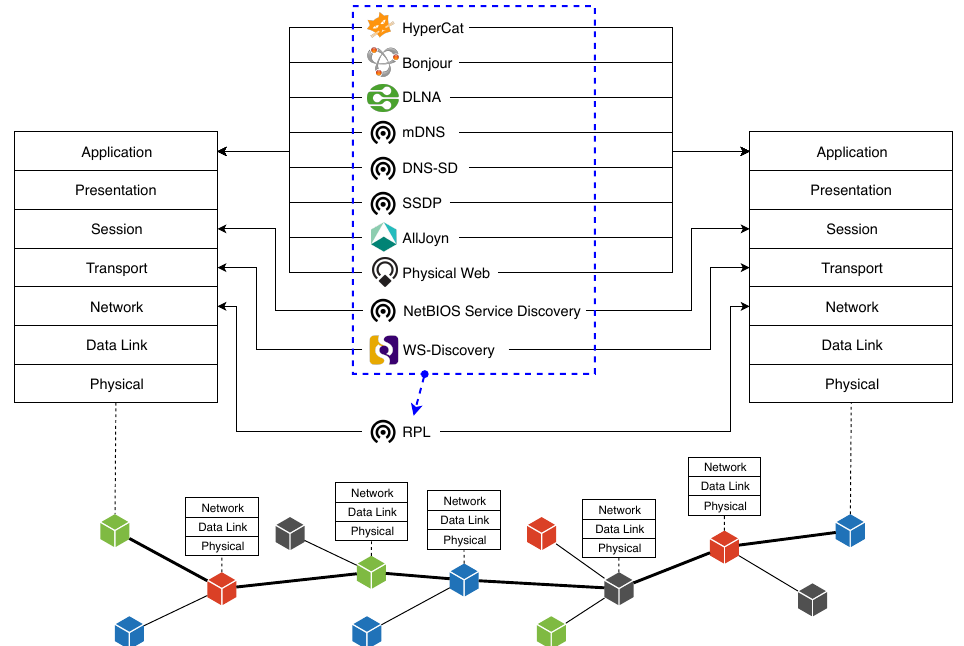
Figure 12. Comparison among different RD/SD protocols operating at various ISO/OSI layers. An illustrative multi-hop path is shown: intermediate nodes use their protocol stacks up to